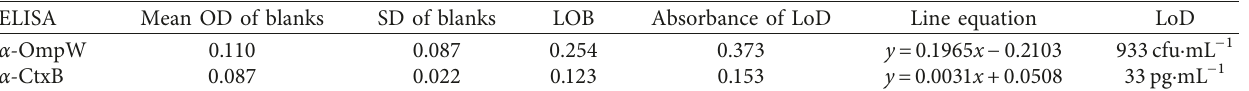
Figure 3: Optimization of α -OmpW and α -CtxB ELISAs. (a) Coating concentration of α -OmpW and (b) HRP-labeled α -OmpW dilutions. (c) Coating concentration of α -CtxB and (d) biotin- α -CtxB dilutions. Table 3: The result of analytical sensitivity calculation for newly developed